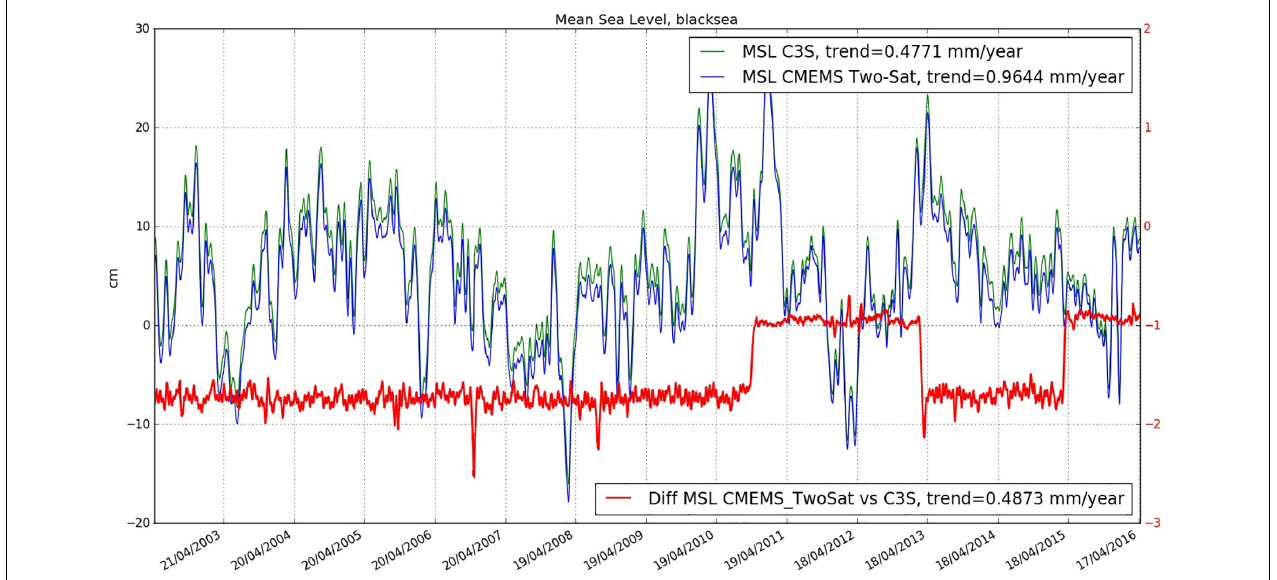
FIGURE 6 | Area-averaged mean sea level in the Black Sea computed with two-satellite merged gridded global datasets including a homogeneous mean sea surface reference field for all missions (in green) and a combined use of a mean sea surface and mean profile of sea surface heights for missions with a drifting or repeat orbit, respectively (in blue). The difference between both regional mean sea level is shown in red (y-axis on the right, in cm).